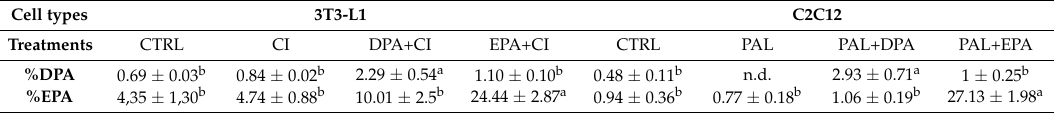
Table 1. Phosphatidylcholine enrichment in EPA and DPA in cells treated with LCn-3PUFA.